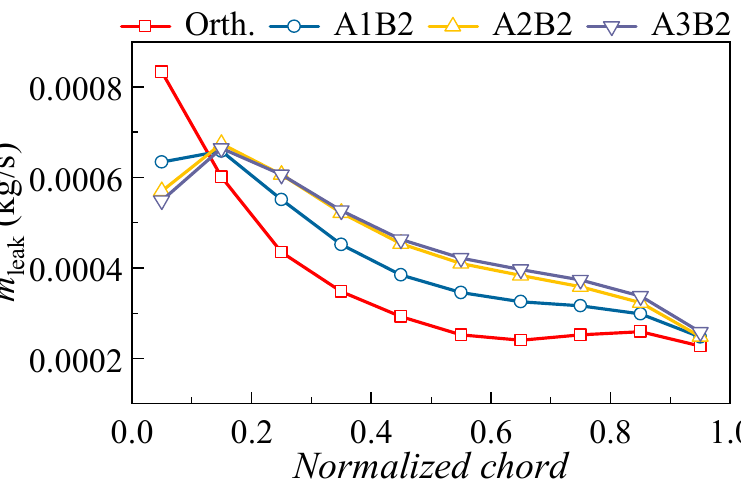
Figure 8. The comparison of the streamwise leakage mass flow rate under different sweep heights ( φ = 0.46).